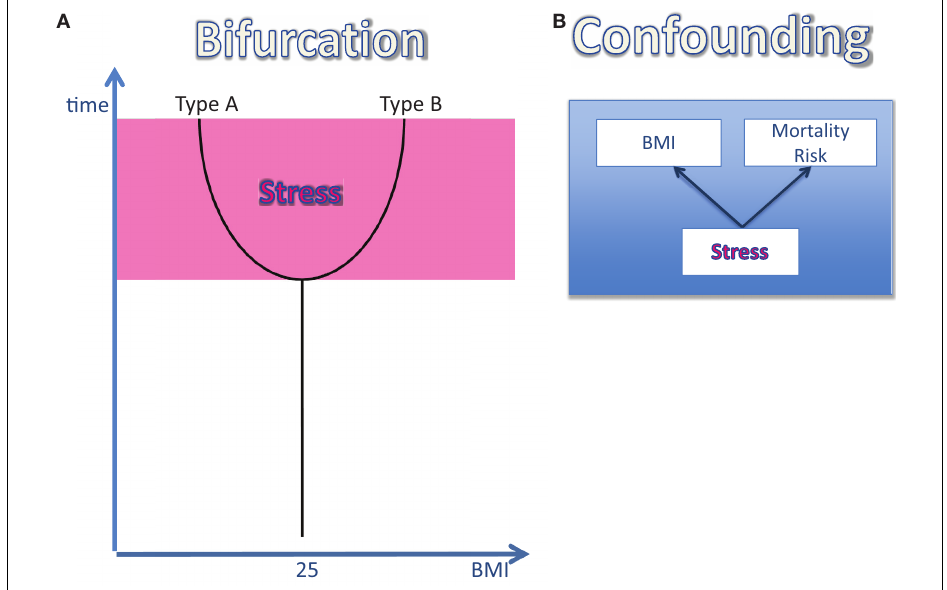
FIGURE 2 | The effect of stress on body weight and mortality risk. (A) The bifurcation of the life course: once an individual is exposed to a stressful environment its body weight changes: in type-A-individuals the body mass index (BMI) decreases, while in type-B the BMI increases. (B) The confounding factor “stress”: stress has been shown to affect both the BMI and the mortality risk. Therefore, stress can be regarded as a confounding factor, which definitely influences the BMI-mortality